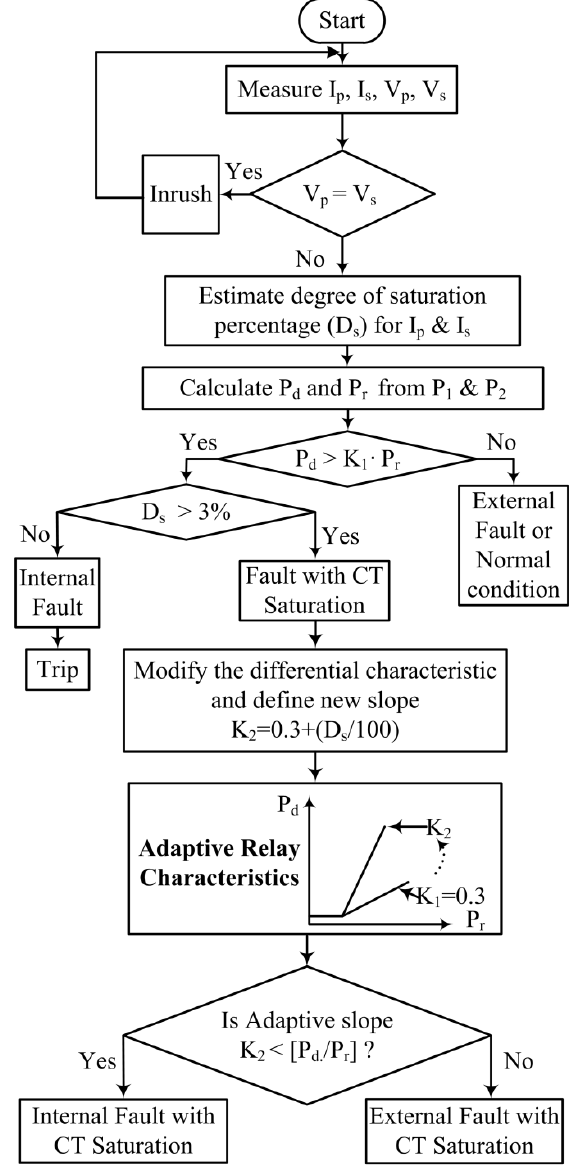
Fig. 4. Proposed adaptive PDP based